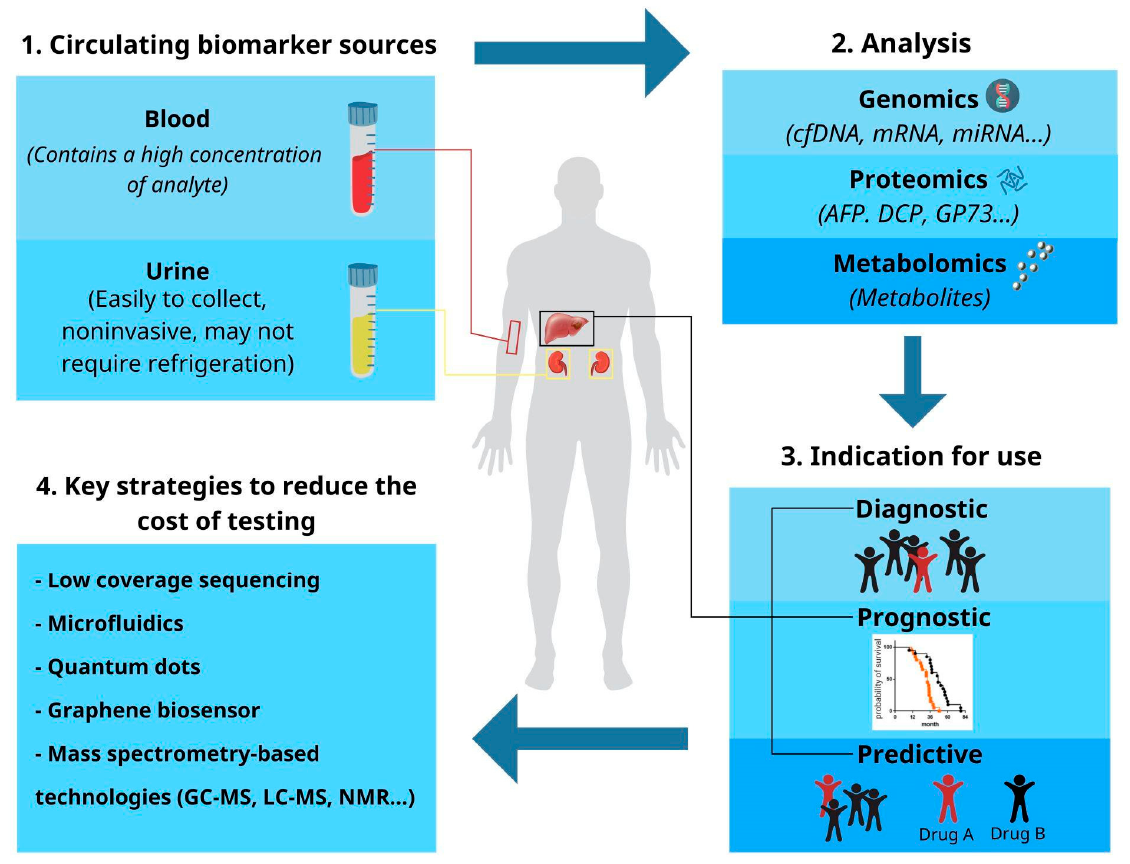
Figure 1. Circulating biomarkers of HCC. Shown are two types of circulating biomarkers (blood and urine, a focus of this review), the proposed strategies to reduce the cost of testing, and their potential applications in LRS for HCC screening, diagnosis, and management.